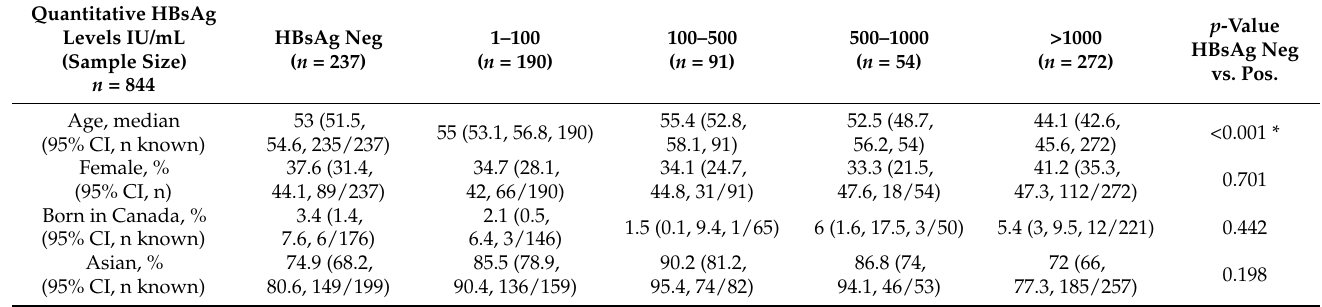
Table 1. Summary of demographic and clinical data for CHB patients who cleared HBsAg vs.